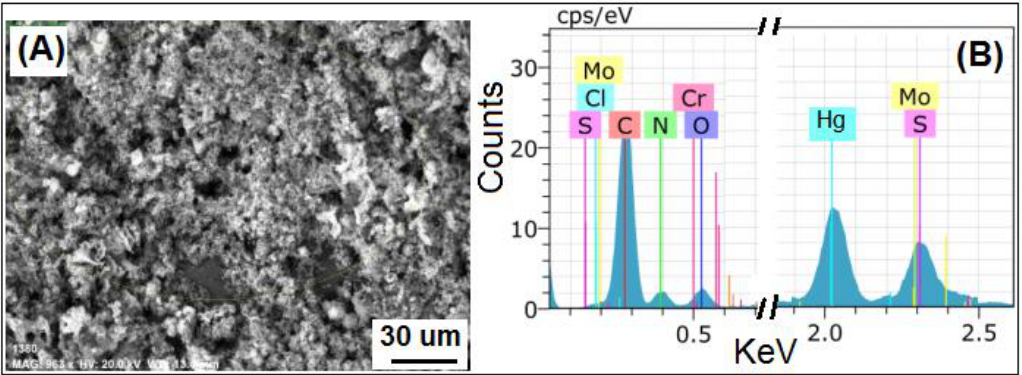
Figure 1. Scanning electron microscope image of ( A ) bare MoS 2 ; ( B ) polyaniline/molybdenum disulfide hybrid nanomaterial (PANI-MOS 2 ) ; and transmission electron microscopy image of ( C ) MoS 2 ; and ( D ) PANI-MOS 2 .